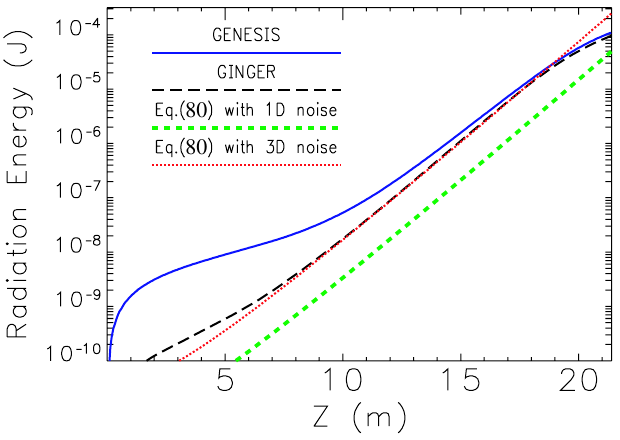
FIG. 6. (Color) GINGER (black) and GENESIS (blue) simulations of the LEUTL FEL energy at 130 nm versus the undulator distance z , as compared from predictions of Eq. (86) with 3D noise (red) and 1D noise